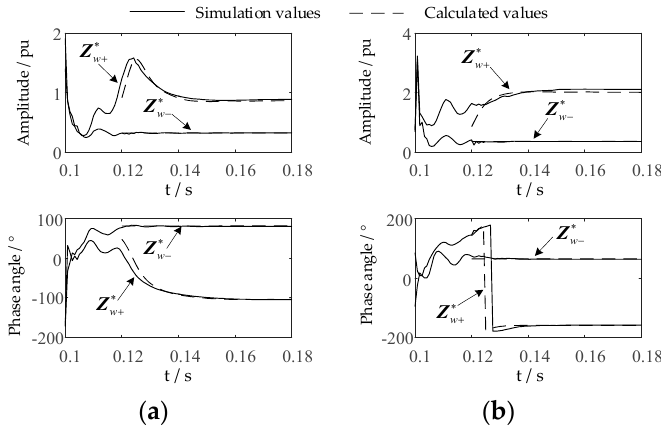
Figure 13. Simulation and calculation values of the superimposed impedance: ( a ) A-phase grounding fault, s = − 0.2, R cb = 20 R r ; and ( b ) B-phase to C-phase fault, s = 0.2, R cb = 60 R r